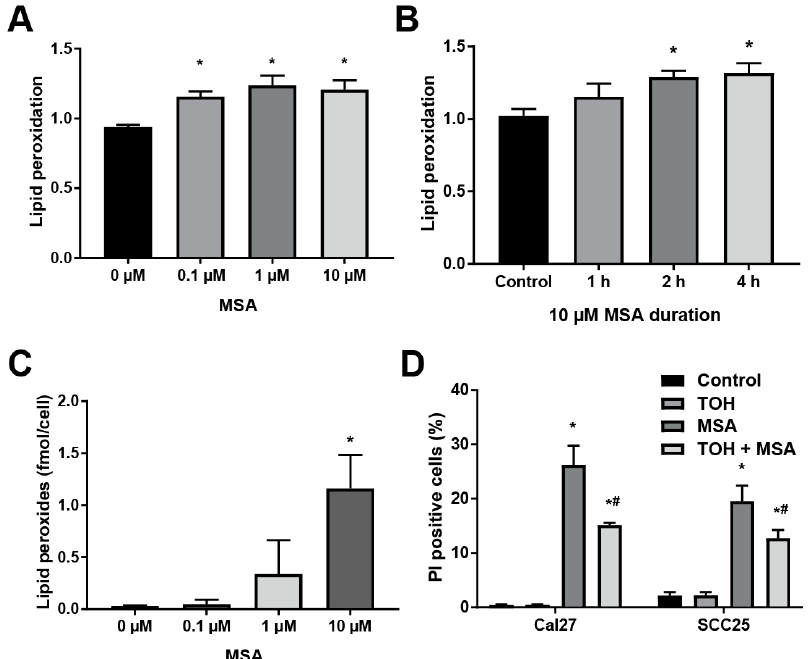
Figure 3. MSA induces lipid peroxidation in HNSCC cells. ( A ) Lipid peroxidation in Cal27 cells assessed by 4,4-difluoro-4-bora-3a,4a-diaza- S -indacene (BODIPY) C-11 staining following 72 h treatment with 0 to 10 µ M MSA. ( B ) Lipid peroxidation in Cal27 cells following treatment with 10 µ M